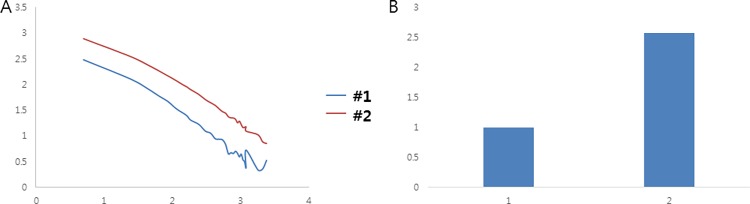
(A) Decay curves in log scale of the best optimized CaAl2O4:Eu2+, Nd3+ crystals(#2) compared with the control CaAl2O4:Eu2+, Nd3+ crystals which is doped with optimized Eu2+ and Nd3+(#1). (B) Relative initial intensity measured at 5s (relative values where the value of control sample #1 is 1.0)